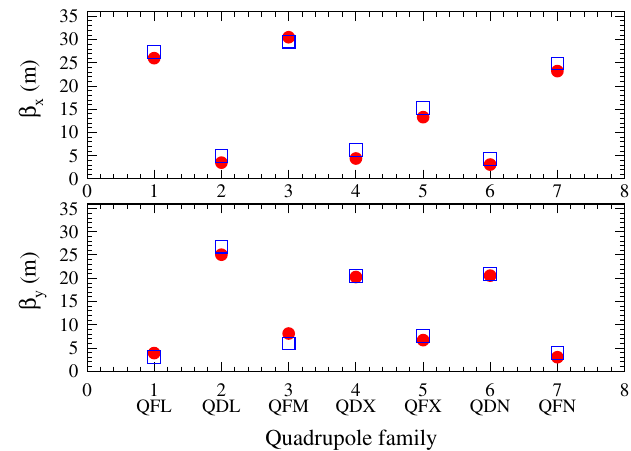
FIG. 22. (Color) Averaged horizontal (upper) and vertical (lower) betatron amplitude functions for each quadrupole family, where closed red circles are those measured at the bottom of the acceleration pattern and open blue squares are for the beam storage